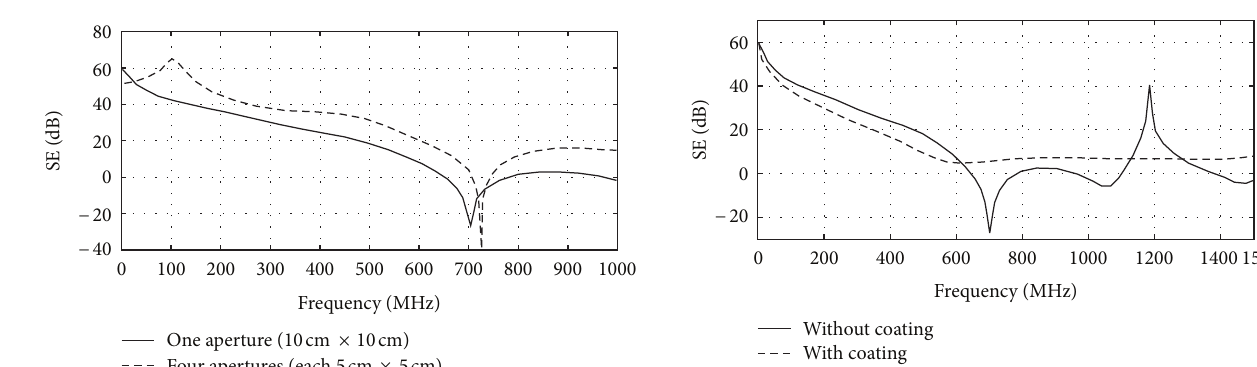
coating−20 Without coating × With Four apertures (each 5 cm × 5 cm) F 14: Shielding effectiveness versus frequency of a 30 box-shaped enclosure with a 10 aperture illuminated by a plane wave at normal incidence in the presence and F 13: Shielding effectiveness versus frequency for a box- absence of a lossy internal coating of 1.5cm × with different shaped enclosure of dimensions 30 12 30cm number of rectangular apertures having the same total area. 3 × ×